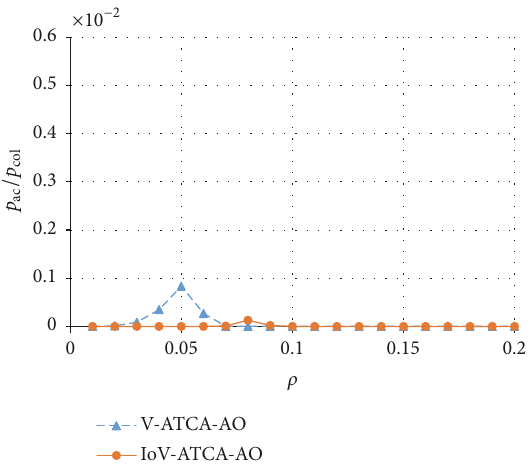
Figure 5: Type II accident rate in two kinds of